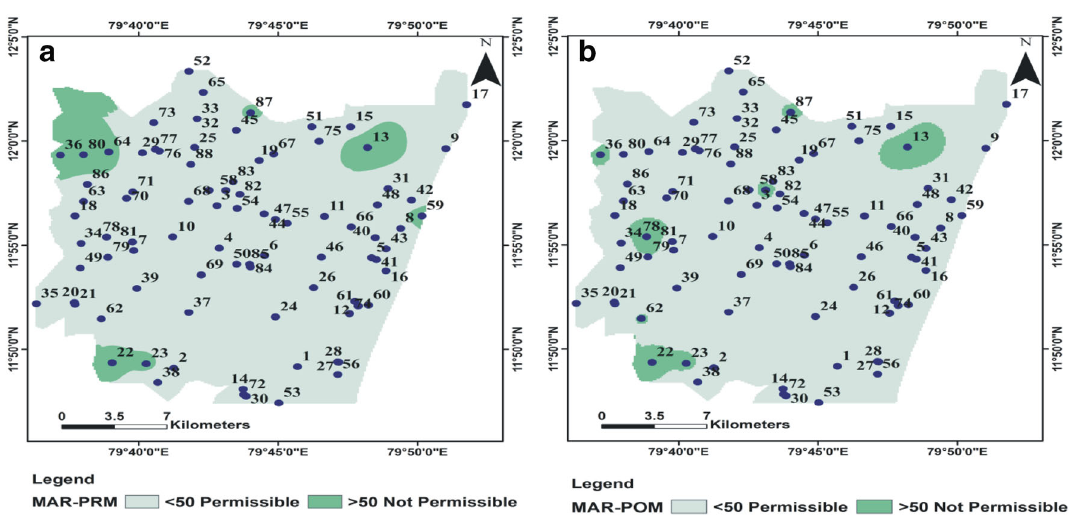
Fig. 14 a , b Spatial distribution map of MAR (pre- and